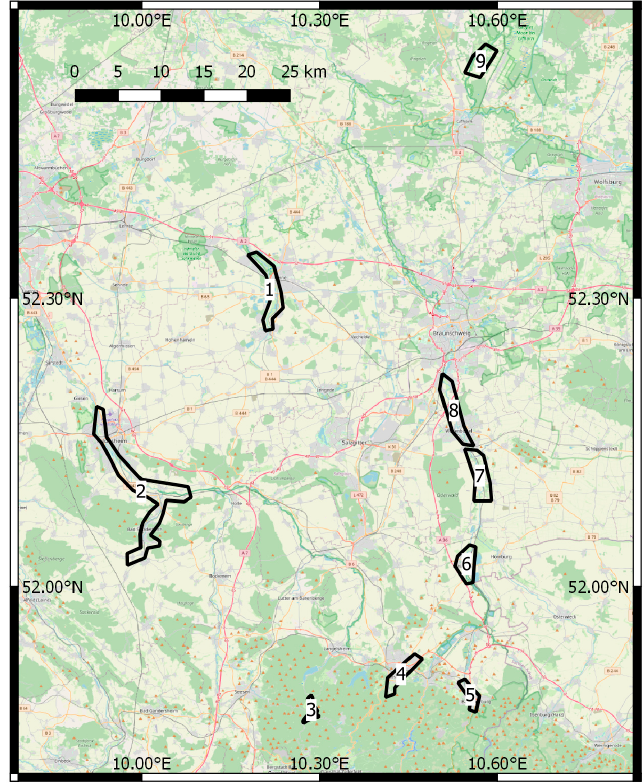
Figure 5. Individual sub-areas selected to validate the flood event close to Hannover in Germany, 2017. Source of background map: Open Street Map (OSM).